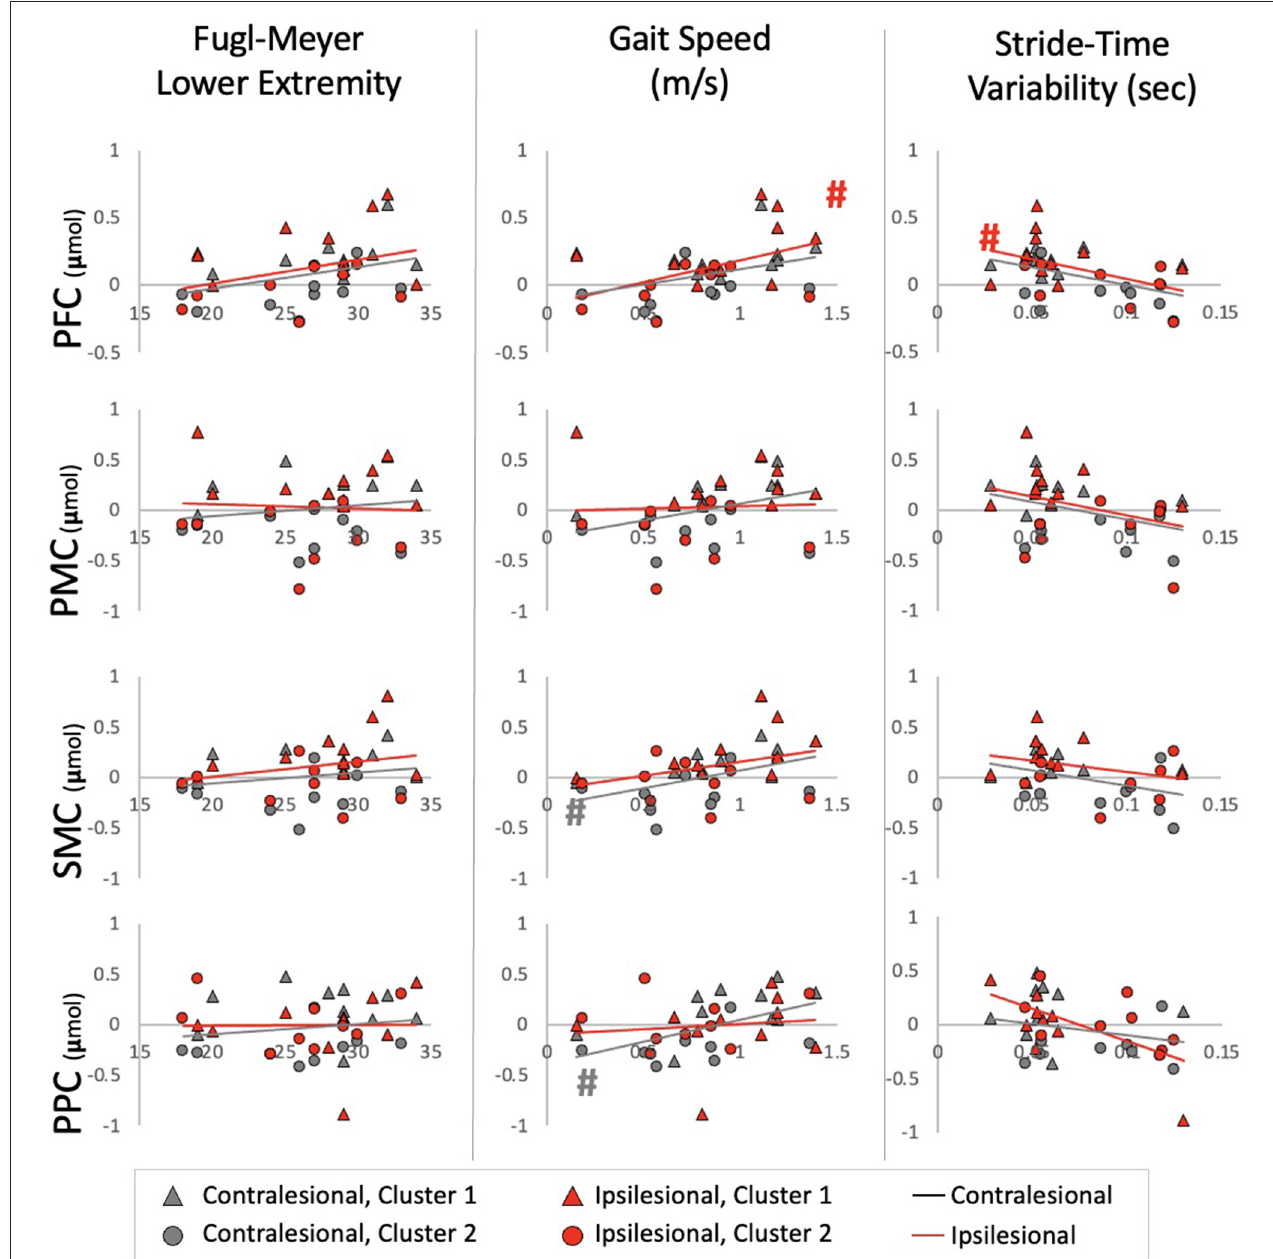
FIGURE 4 | Relationships between HbO and impairment, performance, and automaticity for each ROI Ipsilesional and Contralesional hemisphere are plotted on a single graph and indicated by red and gray markers; respectively. Additionally; individuals in Cluster 1 are denoted by a triangle marker and individuals in Cluster 2 are denoted by circle markers. # Indicates a relationship with alpha at